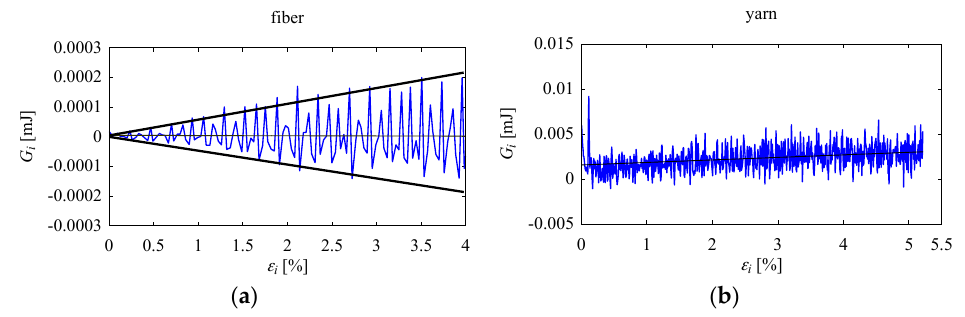
Figure 8. Comparison between ( a ) jute fiber and ( b ) jute yarn (copy of Figure 6a) in terms of energy difference.